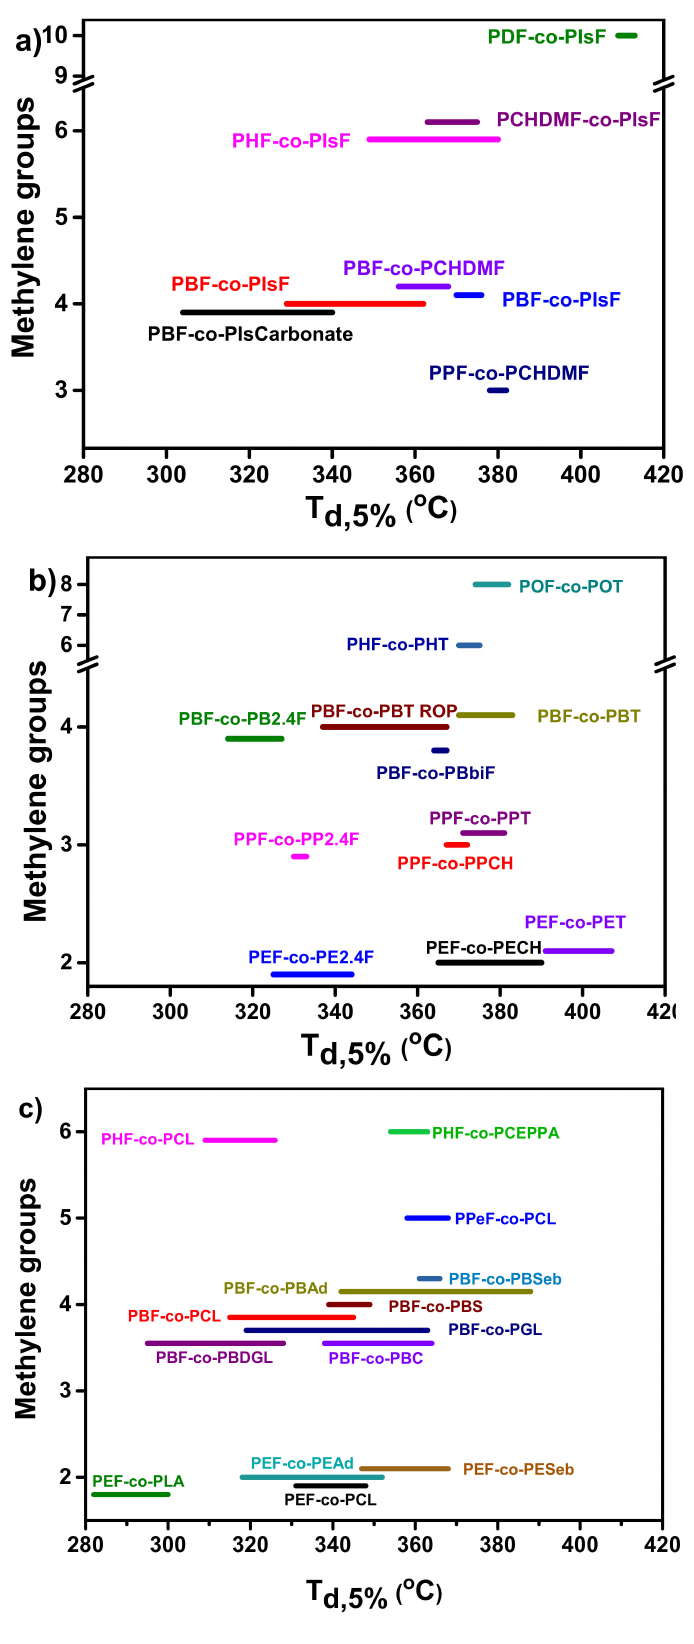
Figure 11. E ff ect of the number of methylene groups and the comonomer used on the T d,5% of FDCA-based copolyesters: ( a ) with cyclic diols [59,65,68,70,97,99,100], ( b ) with cyclic dicarboxylic acids [28,42,51,61,63,64], and ( c ) with acyclic diacids and α hydroxy acids